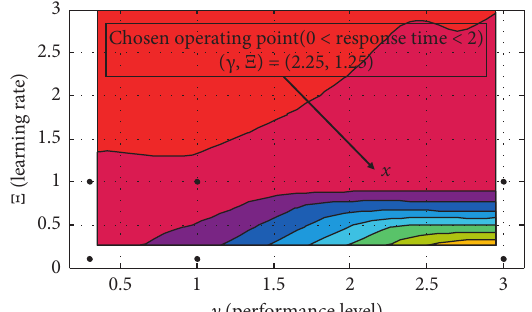
Figure 19: The effectiveness estimation algorithm response time vs. learning rate and performance